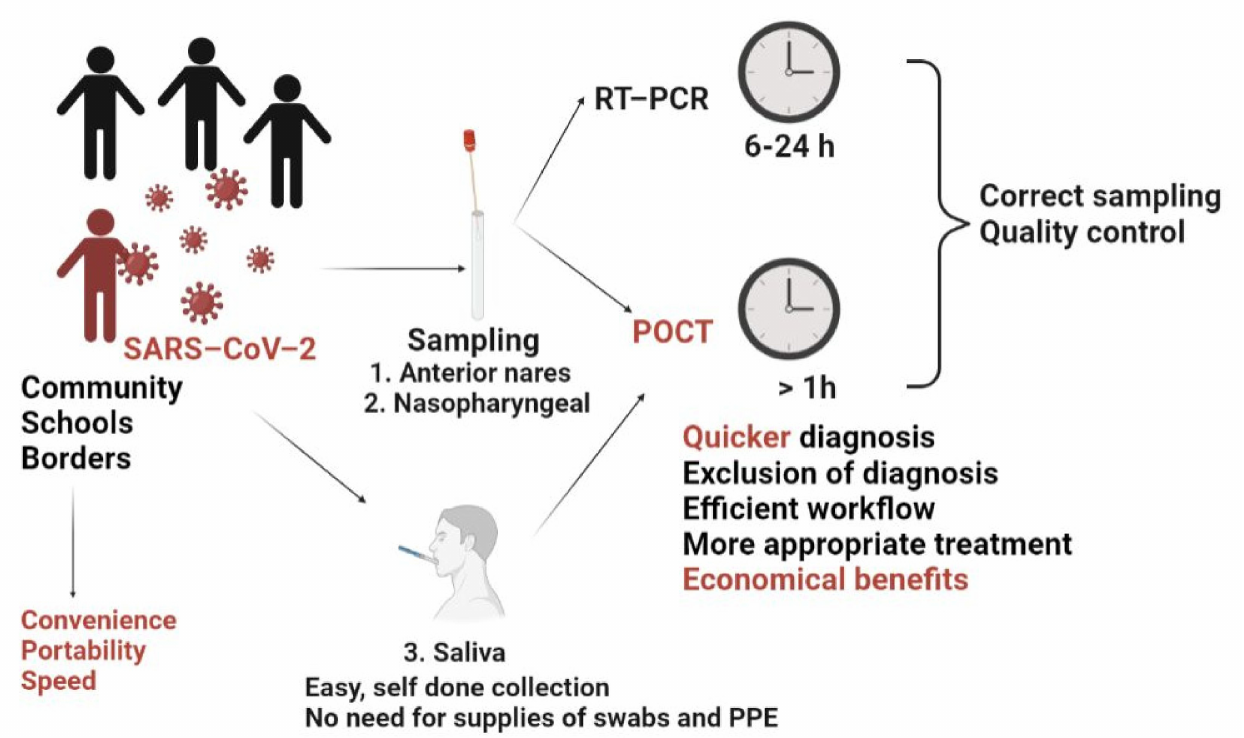
Figure 2. Point-of-Care Testing (POCT) advantages for the diagnosis and surveillance of SARS-CoV-2